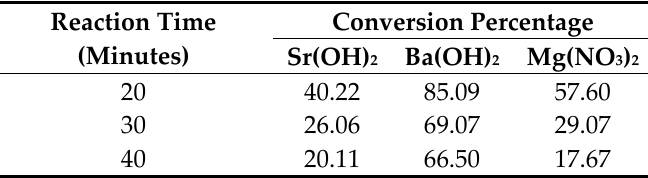
Table 2. Conversion percentage in carbonation